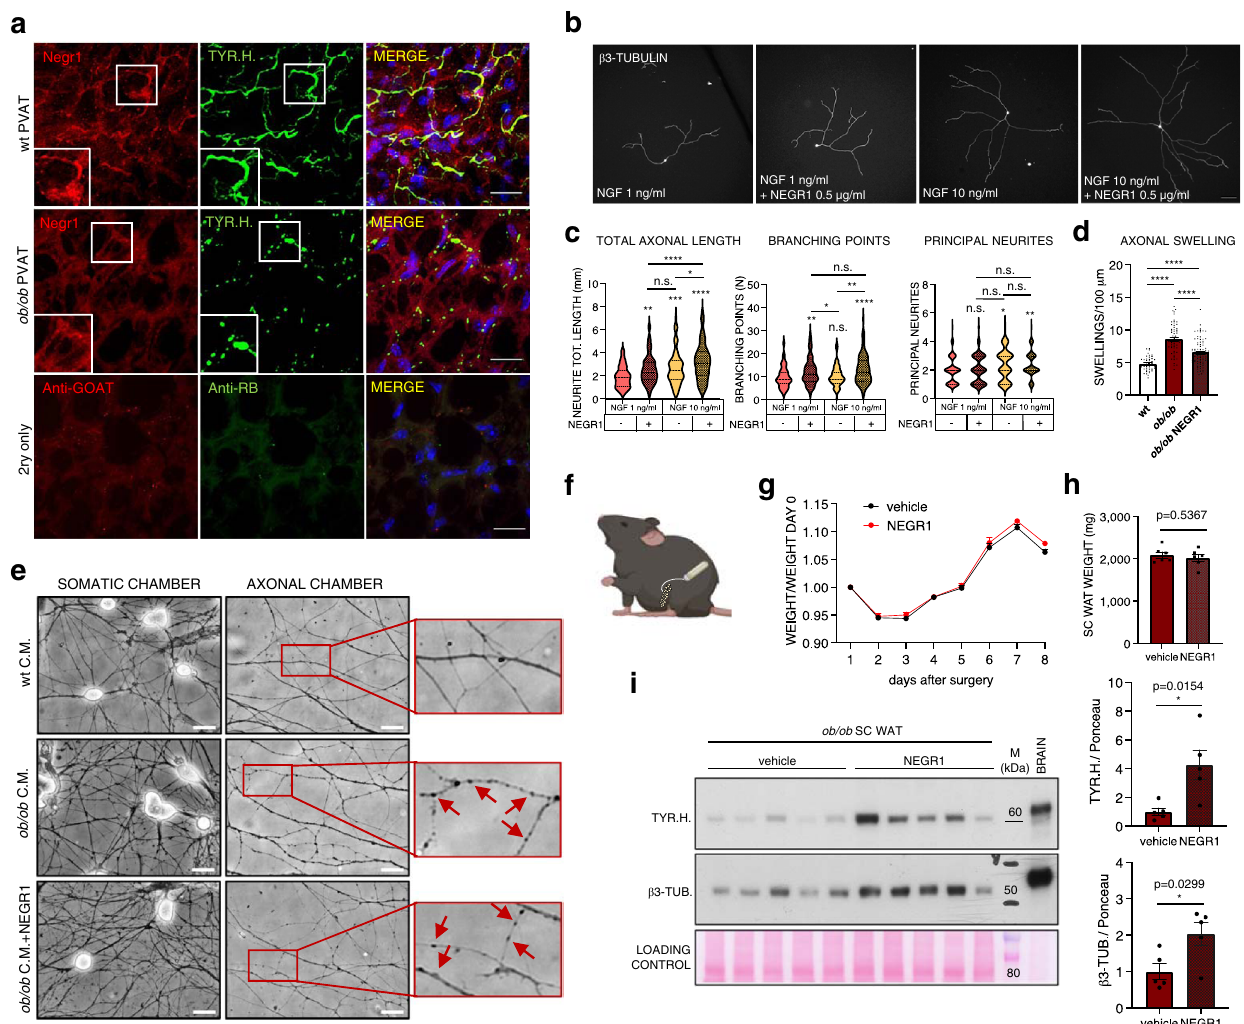
Fig. 7 | Negr1 exerts a trophic effect on sympathetic neurons. a Immuno fl uoescenceimagesshowingNegr1andTYR.H.distributioninwtand ob/ ob TH PVAT sections (from 1 out of 2 replicates).Insets show higher magni fi cation of framed areas. Nuclei are counterstained with DAPI. Scale bar: 50 µ m. b RepresentativemicrographsofSCGsympatheticneuronsculturedatlowdensity for 24h in presence of 1 or 10ng/ml NGF, with or without 500ng/ml recombinant Negr1, and stained for β 3-tubulin. Scale bar: 100 µ m. c Quanti fi cations of